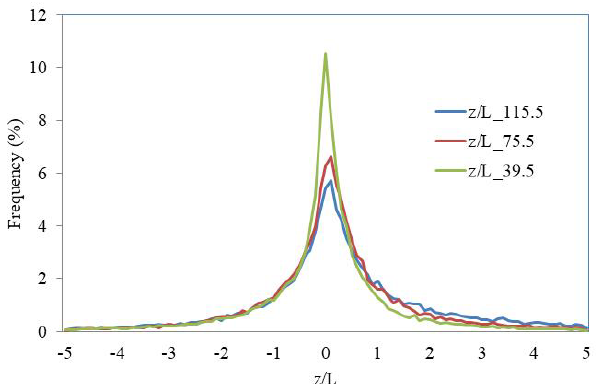
Figure 4. Probability distribution of z/L at all the sonic heights. Only concurrent time steps between July 2014 and June 2015 are included.